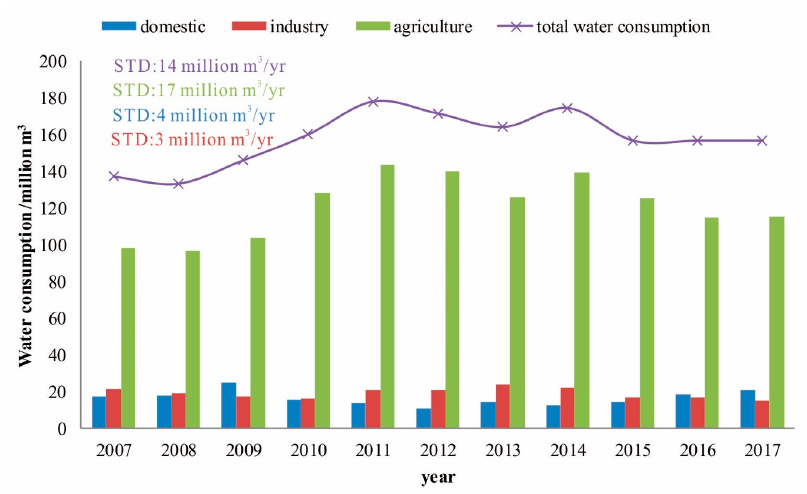
Figure 6. The changes in groundwater exploitation in various industries. STD: interannual standard deviation of water consumption.